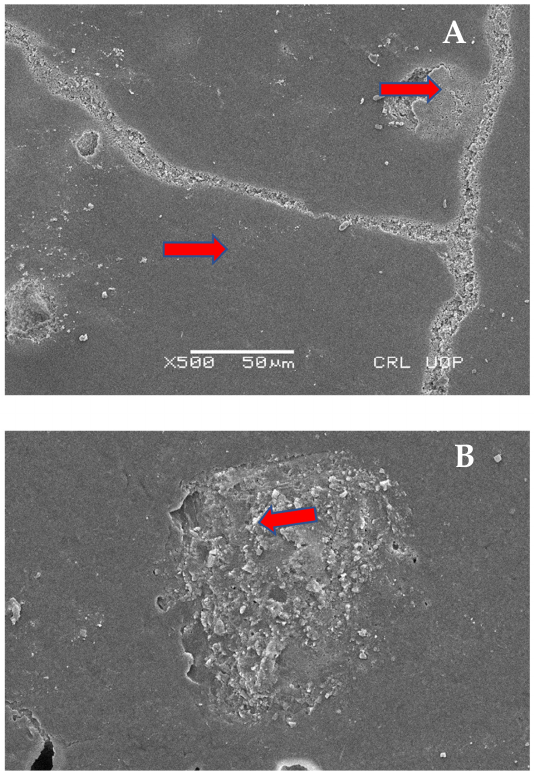
Figure 9 . Failure mode of GIC + Spectrum (Group C), adhesive failure under scanning electron microscope. Red arrows indicate adhesive failure regions, ( A ) at 500×, and ( B ) at 1000×.